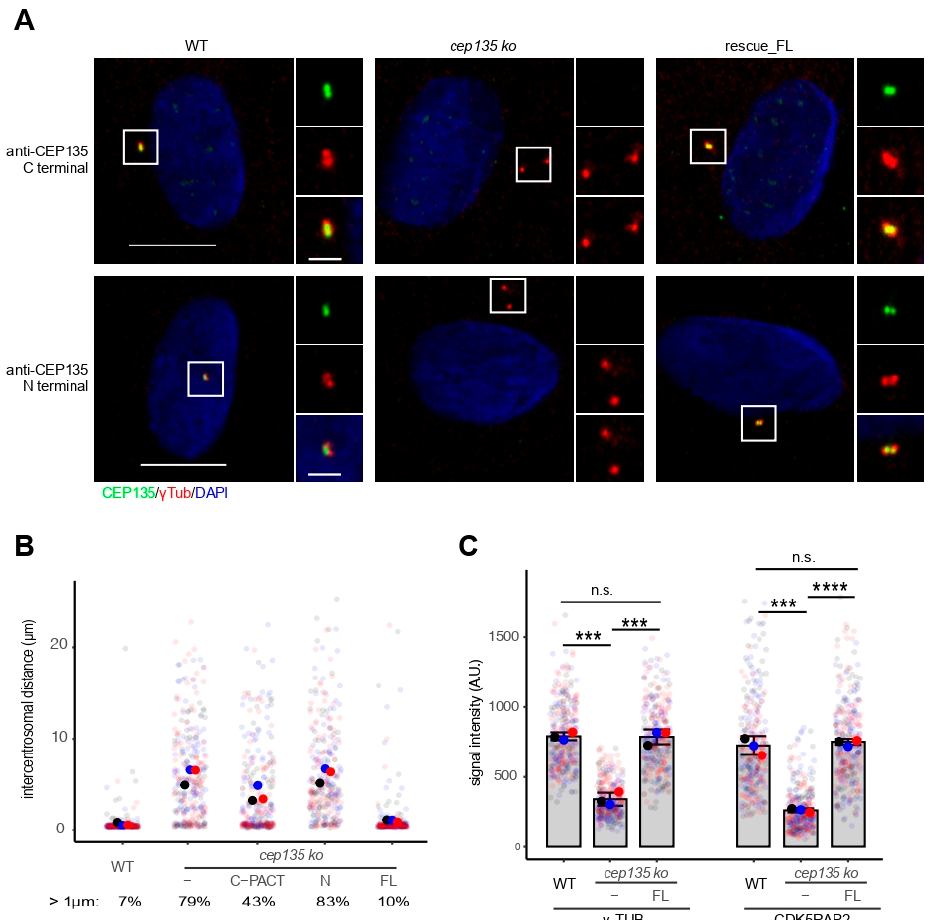
Figure 6. CEP135 expression rescues defects in cep135 KO cells. ( A ) Representative immunofluo- rescence images showing exogenous CEP135 expression in cep135 KO cells with antibodies against both N- and C-termini of CEP135. Scale bar: 10 µ m or 2 µ m (insets). ( B ) Centrosomal distance after nocodazole treatment in WT, cep135 KO, and rescue cells stably expressing either full-length CEP135, the N-terminus domain of CEP135, or the C-terminus with the centrosomal targeting (PACT) domain of CEP135. ( C ) Quantification of γ -tubulin and CDK5RAP2 signals in WT, cep135 KO, and rescue cells. ( B , C ) Graphs show mean values (fat colored/black dots) of single experiments and individual data points (transparent dots) with error bars representing the SD from three independent experiments (300 cells measured for each condition). The p -value was calculated with a two-tailed Student’s t -test. *** indicates p < 0.005, **** p <